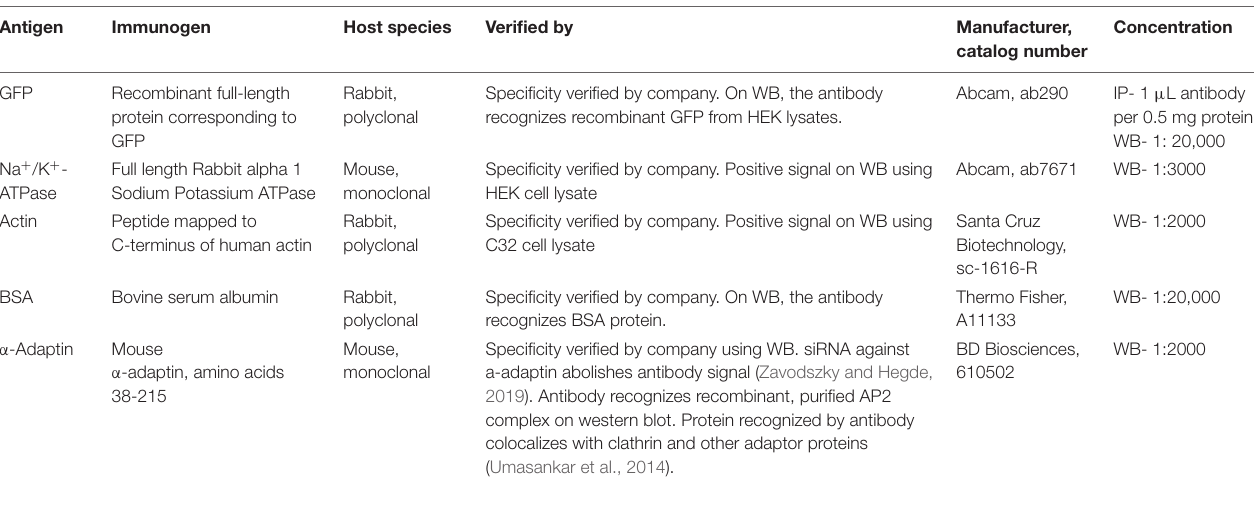
TABLE 1 | Primary